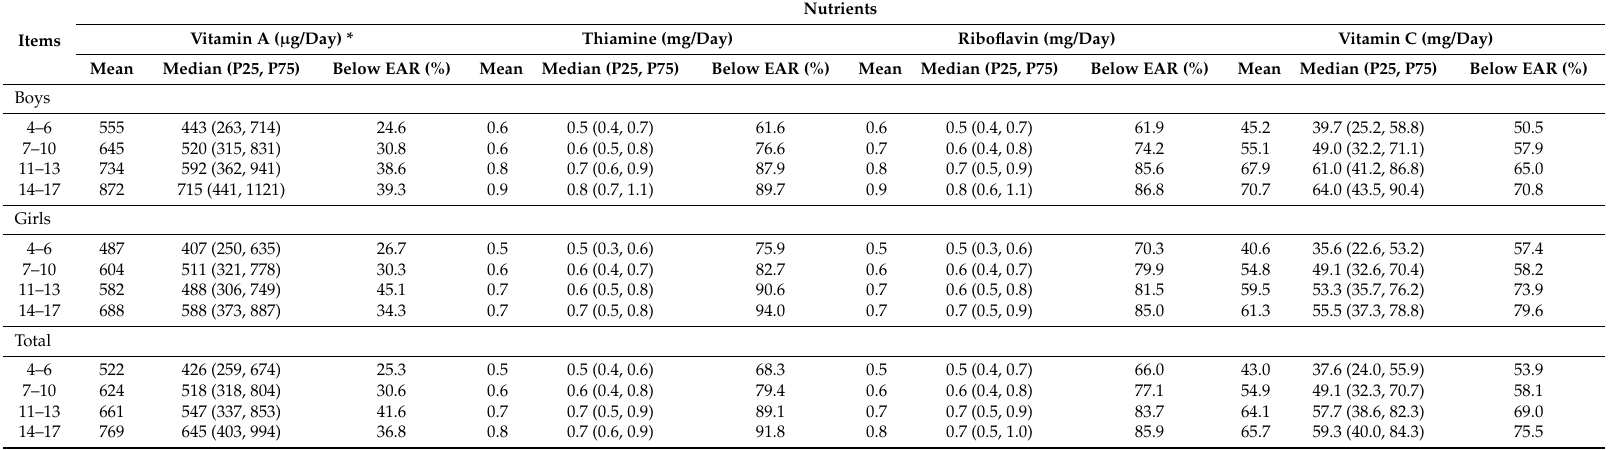
Table 4. Usual daily intake and proportion below the EAR for vitamin A, thiamine, riboflavin and vitamin C among Chinese